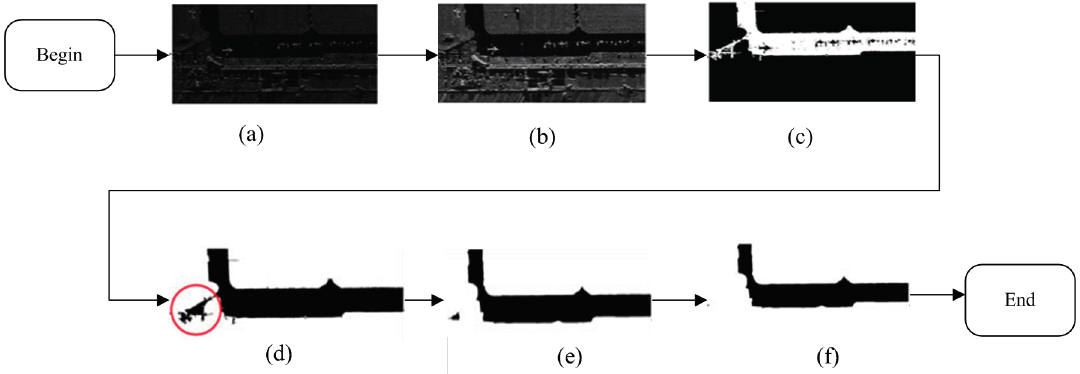
Figure 4. The intermediate results of the apron and holes-on-apron detection. ( a ) is the original real SAR image for example; ( b ) is the preprocessed image after enhancing image and suppressing speckles in ( a ); ( c ) is the sketch map of candidate region map after segmenting image by bimodal method, and labeling the largest connected component on ( b ), the black regions on white apron area is the candidate regions; ( d ) is the original apron area image after filling holes on apron area (candidate regions) on ( c ); ( e ) is the dilated image after applying binary-morphologically dilating on ( d ); ( f ) is the final more precise apron area after doing fill holes on ( e ) to eliminate small regions which are not on apron